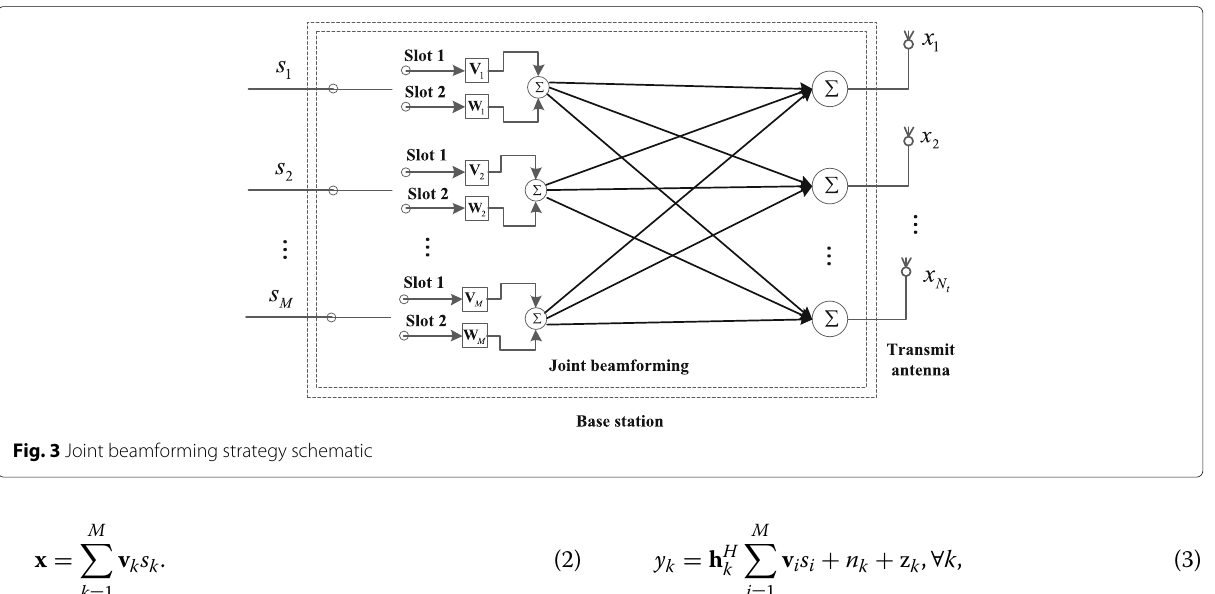
Fig. 3 Joint beamforming strategy schematic